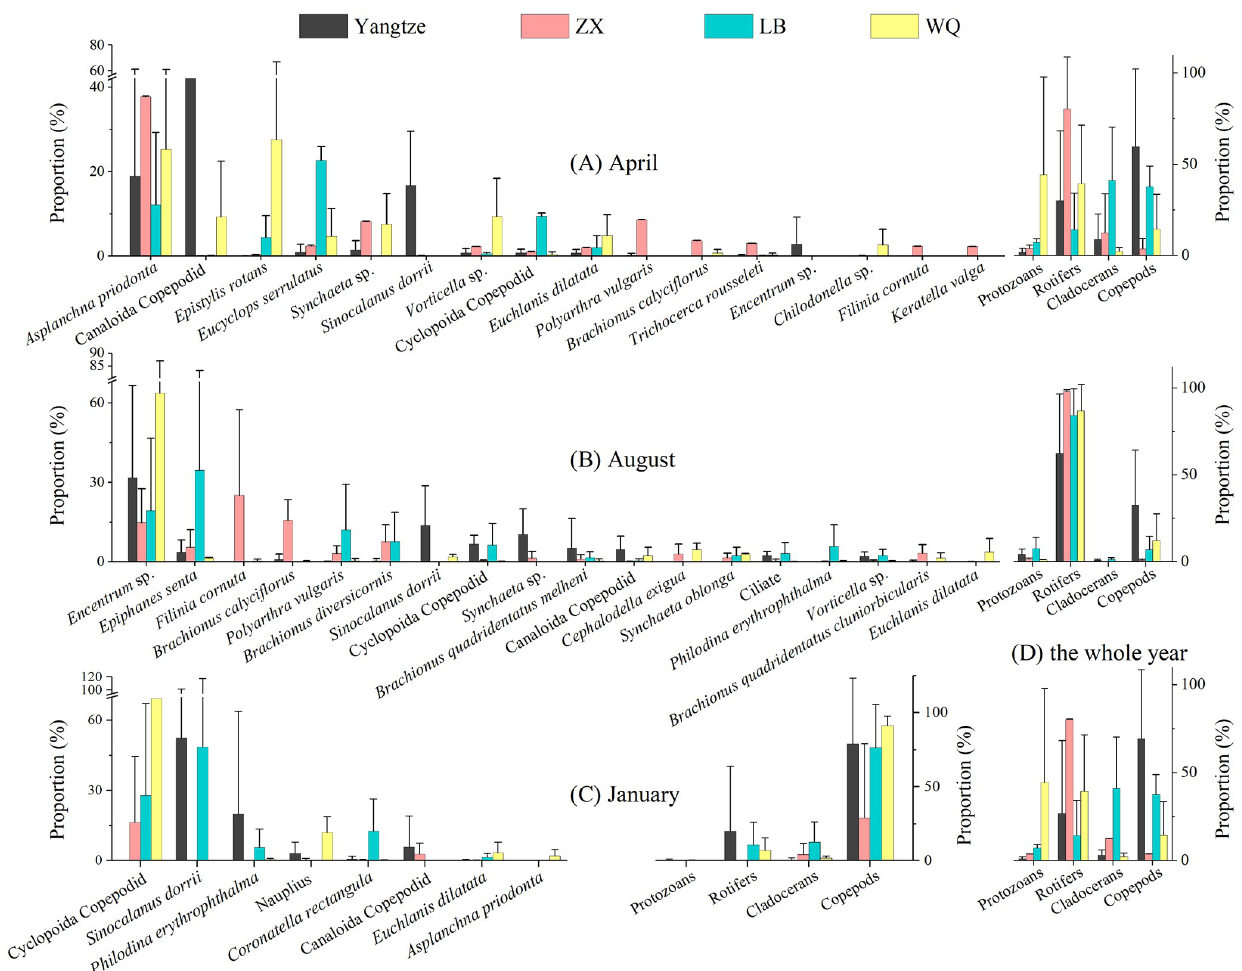
Fig 4. Spatio-temporal patterns in zooplankton communities based on the biomass data. The sampling season was April at MWL (A), August at LWL (B) and January at HWL (C), respectively. The four categories of zooplankton in the three seasons were also summarized (D). Only showed those species with average proportion > 2% in each river and frequency � 5. Yangtze = the Yangtze River, ZX = Zhuxi River, LB = Longbao River, WQ = Wuqiao River, The same below.